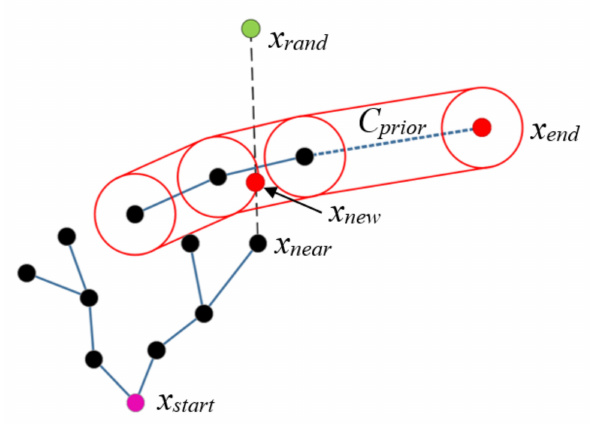
Figure 4. Generation of x new